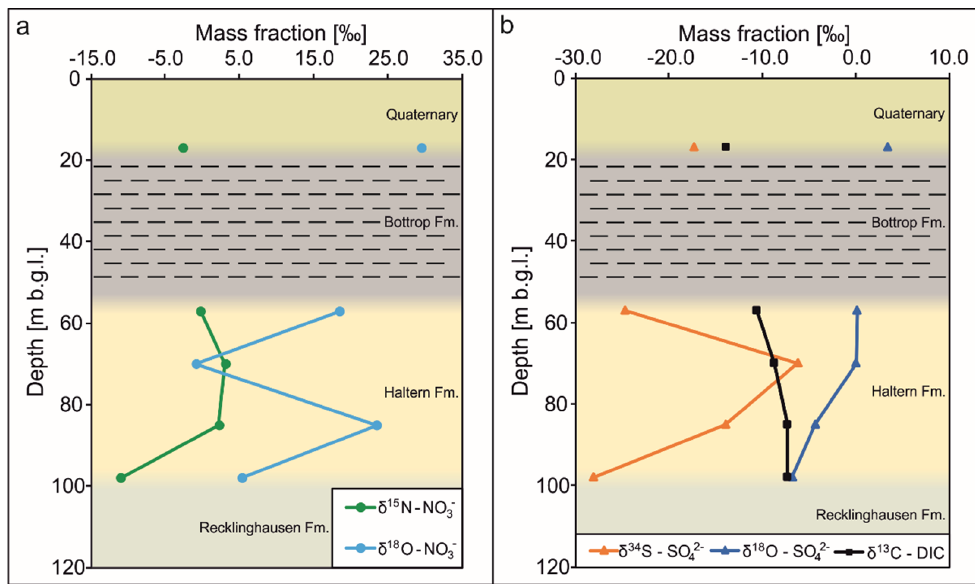
Figure 10. Isotope ratios in the groundwater of the Haltern Fm. aquifer. ( a ) δ 15 N-NO 3 − and δ 18 O-NO 3 − . ( b ) δ 34 S-SO 42 − , δ 18 O-SO 42 − , and δ 13 C-DIC.